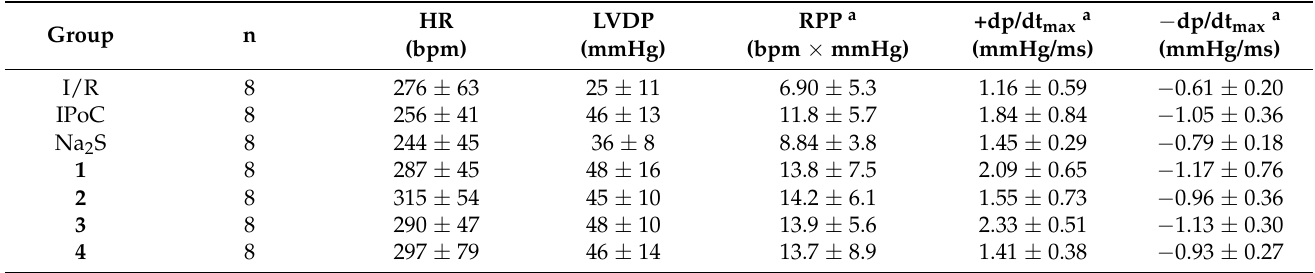
Results are expressed as the mean ± SEM using values obtained at 90 min of reperfusion normalized to the respective pre-ischemic value (n = 8 in each group) * p , 0.05, ** p , 0.005, *** p , 0.001, **** p < 0.0001 vs. I/R-Control. Table 2. Isolated heart parameters observed at the end of reperfusion in the different treatment